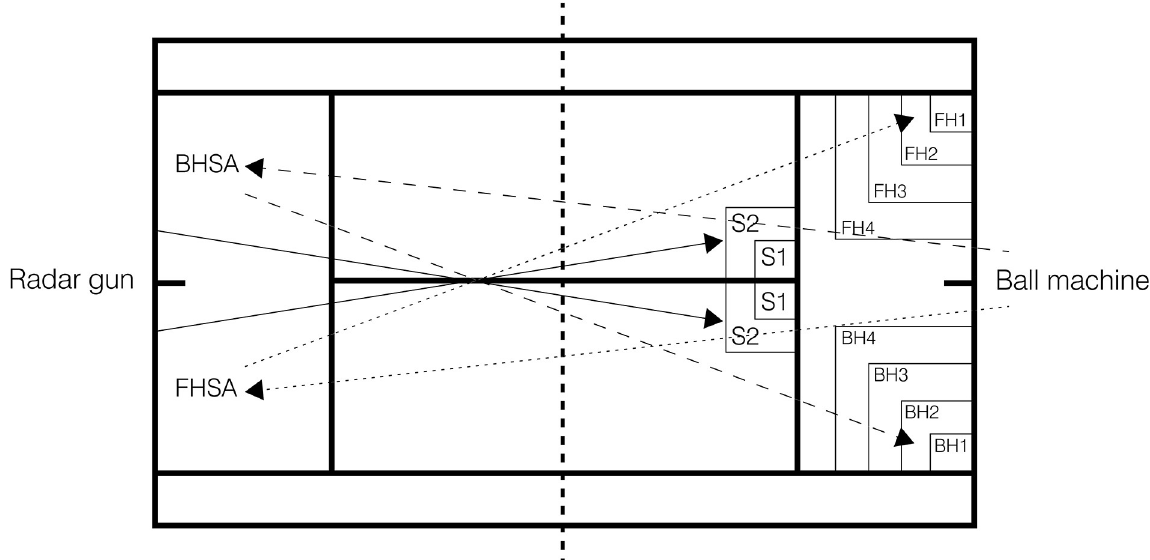
Fig 2. Stroke performance test [23]. S = serve; FH = forehand; BH = backhand. S1 and S2: Target area for the serve; FH1, FH2, FH3 and FH4: Target area for the forehand; BH1, BH2, BH3 and BH4: Target area for the backhand; FHSA: Forehand stroke impact area; BHSA: Backhand stroke impact area. Continuous line: Serve trajectory; dot line: Forehand trajectory; dash line: Backhand trajectory.